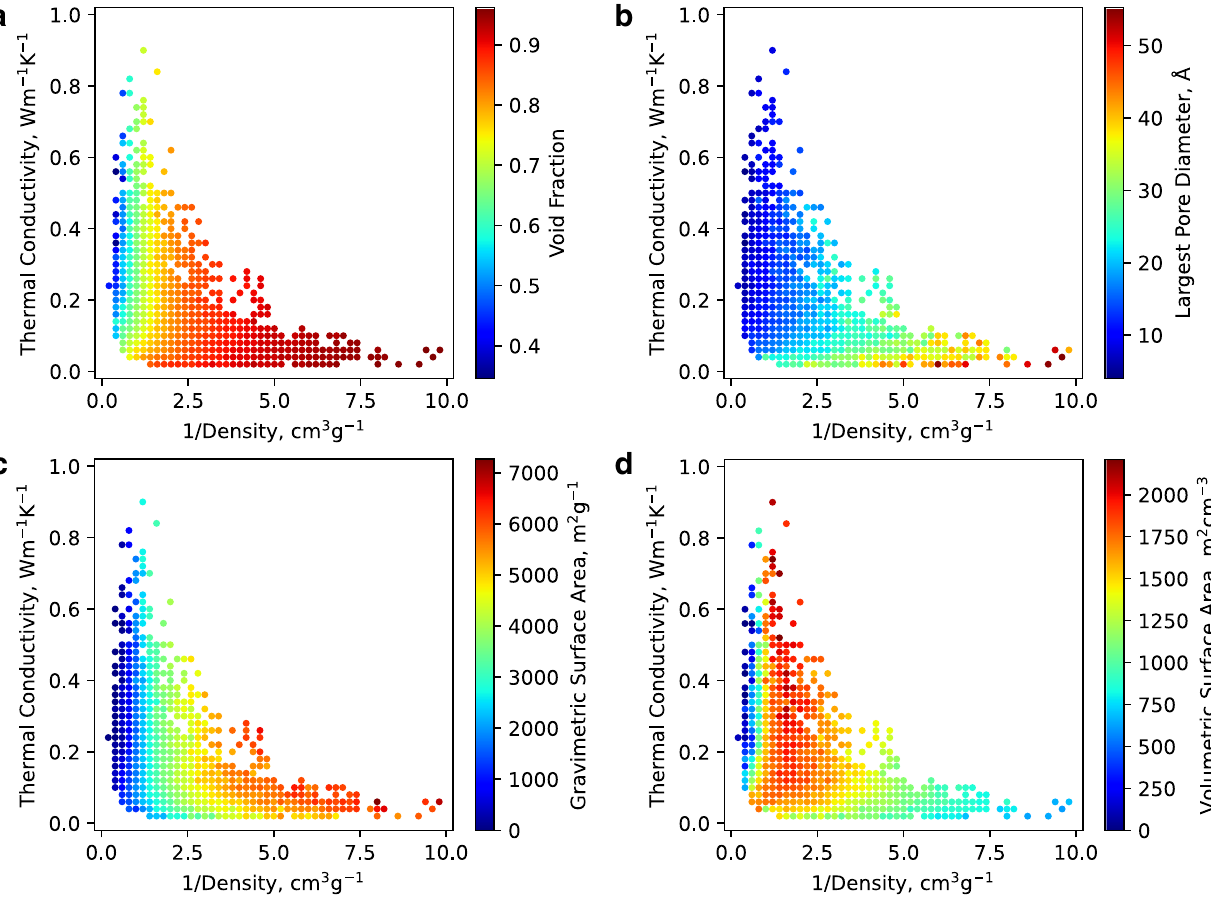
Fig. 3 Relationships between average thermal conductivity and inverse density. Figure panels are colored by a void fraction, b largest pore diameter, c gravimetric surface area, and d volumetric surface area. Each plot is divided into 50 × 50 bins which are illustrated by a fi lled circle, whose color represents the averaged property across all MOFs in that bin. Bins with less than three structures are not shown to reduce